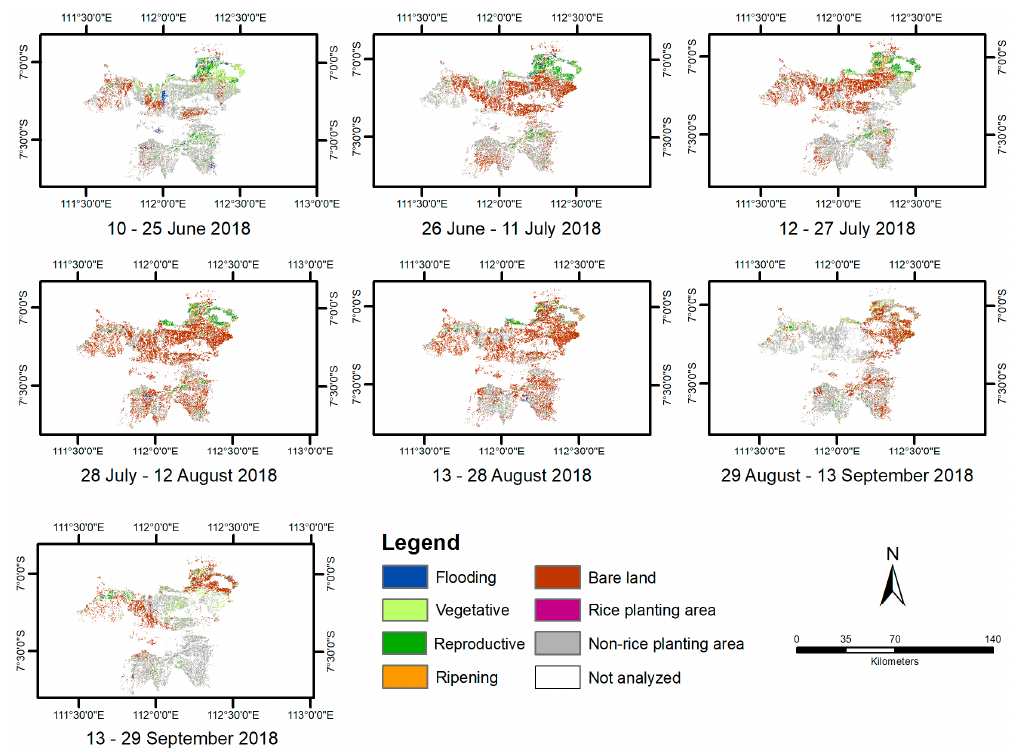
Figure 8. Temporal map of rice growth stages based on Sentinel-2/MOD13Q1/Sentinel-1 on the East Area.